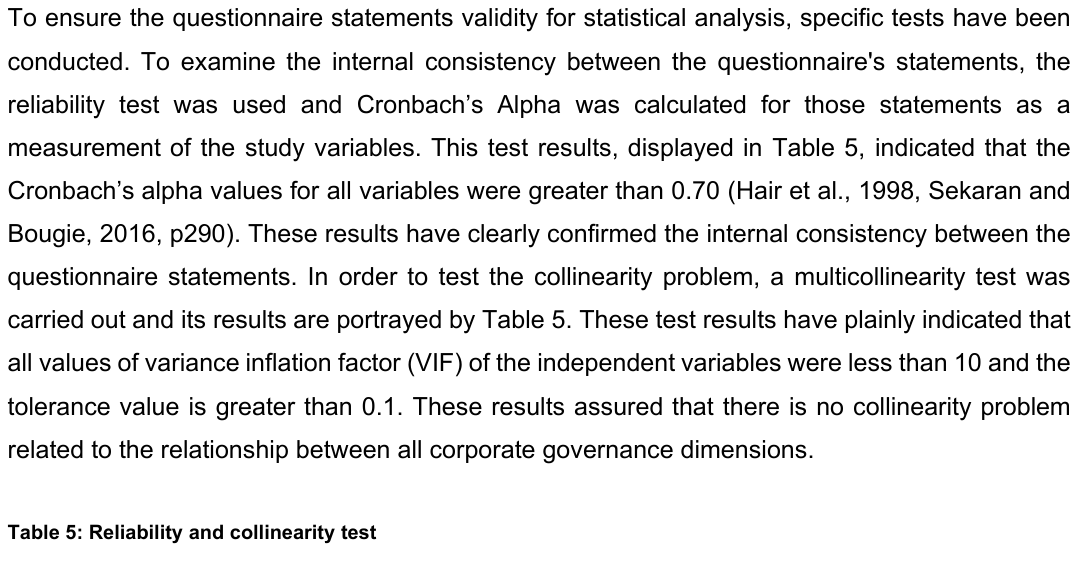
Table 5: Reliability and collinearity